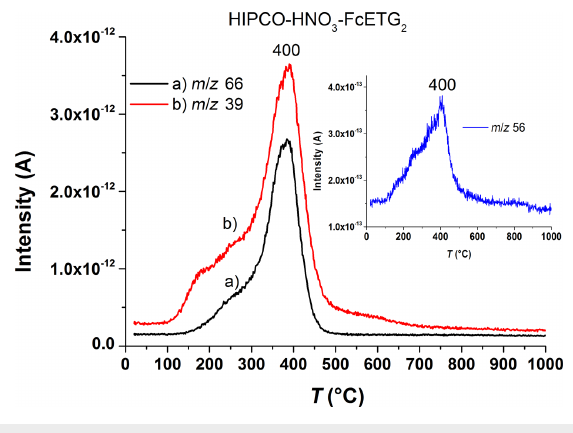
Figure 7: Mass spectrometry channels used to show the departure peaks of the cyclopentadienyl group and its main fragments at m/z = 66 and m/z = 39. Inset: the departure peak of the iron atoms of the ferrocene groups.